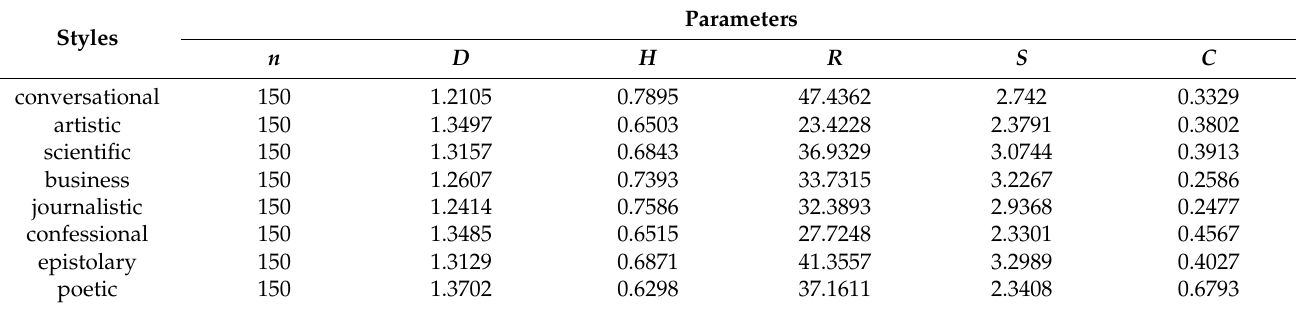
Table 3. Parameters of the different